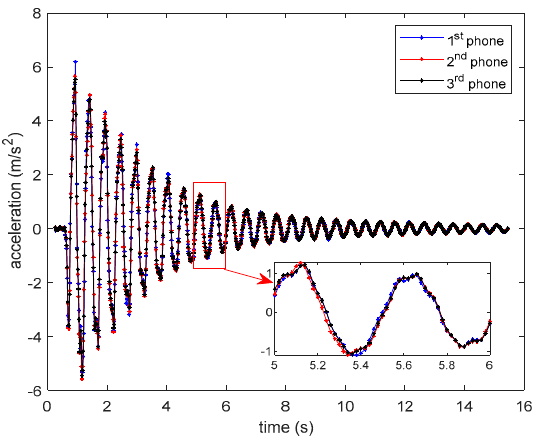
Figure 12. Smartphones’ measured structural responses.